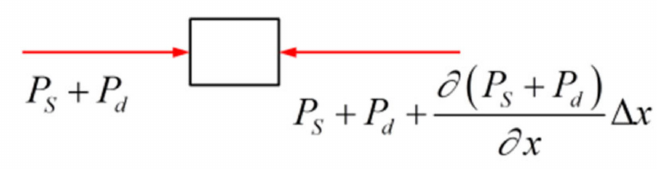
Figure 4. Sample micro-force of static and dynamic